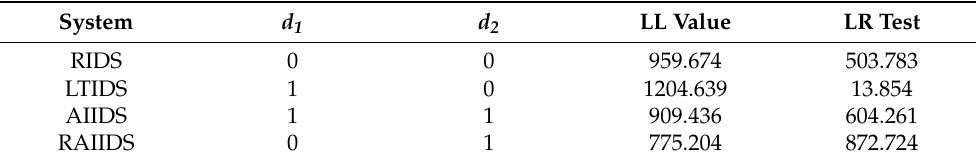
Table 3. Log-likelihood of nested systems, and comparison with the synthetic inverse demand system.